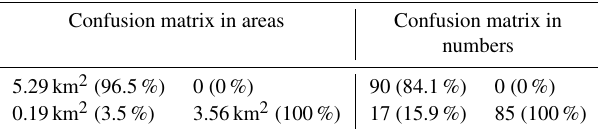
Table 3. Confusion matrix (Table 2) in areas and numbers for the study area of Chamonix. For the PRA detection and the determina- tion of the validation sample, all factors and the DEM resolution are set to their default values (Figs. 3–4) and forest cover data are from DB forest